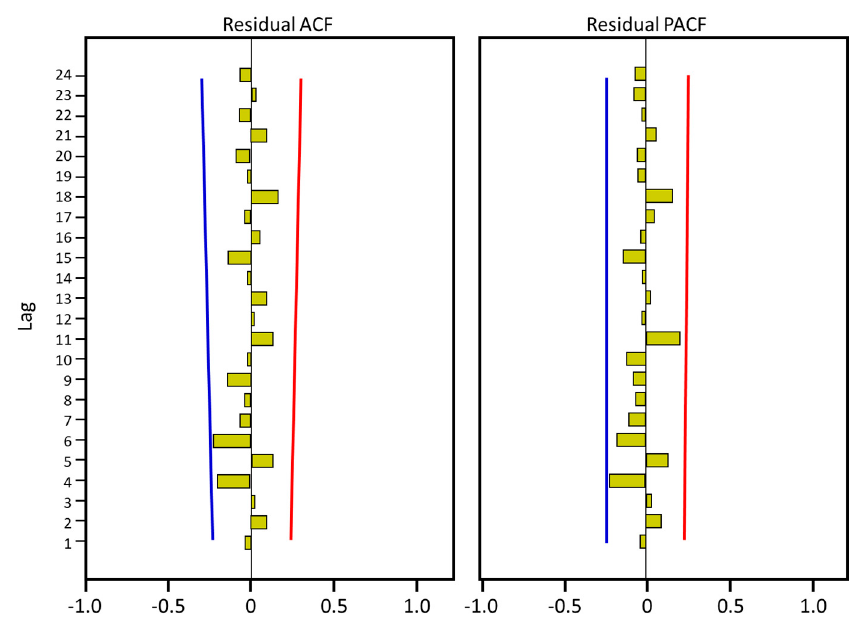
Figure 2. ACF and PACF plots for generation of organic waste.